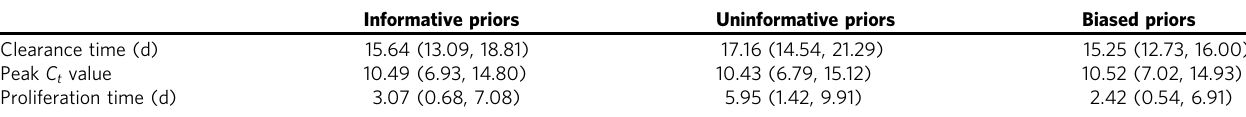
Table 2 Estimated viral trajectories for different priors presented as means with the 95% con fi dence interval (CI) in